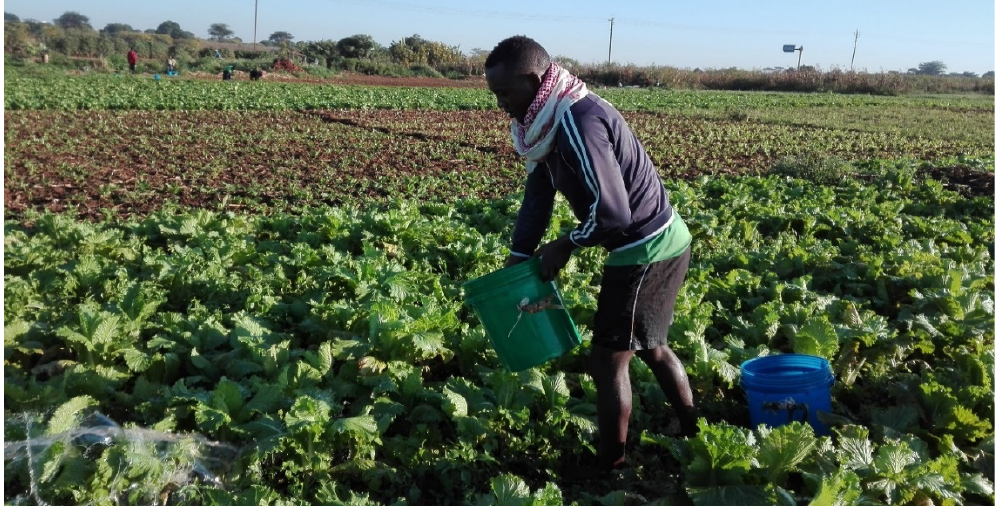
Figure 1. Chinese cabbage plots in a vegetable farm of Lubumbashi.